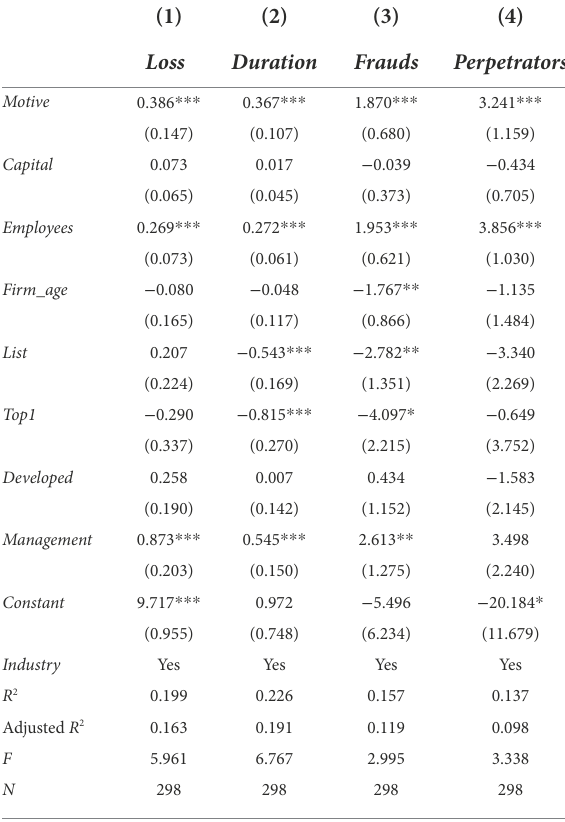
TABLE 10 Predictive validity test of the employee fraud motive scale. TABLE 8 Definitions of the variables in predictive validity test.